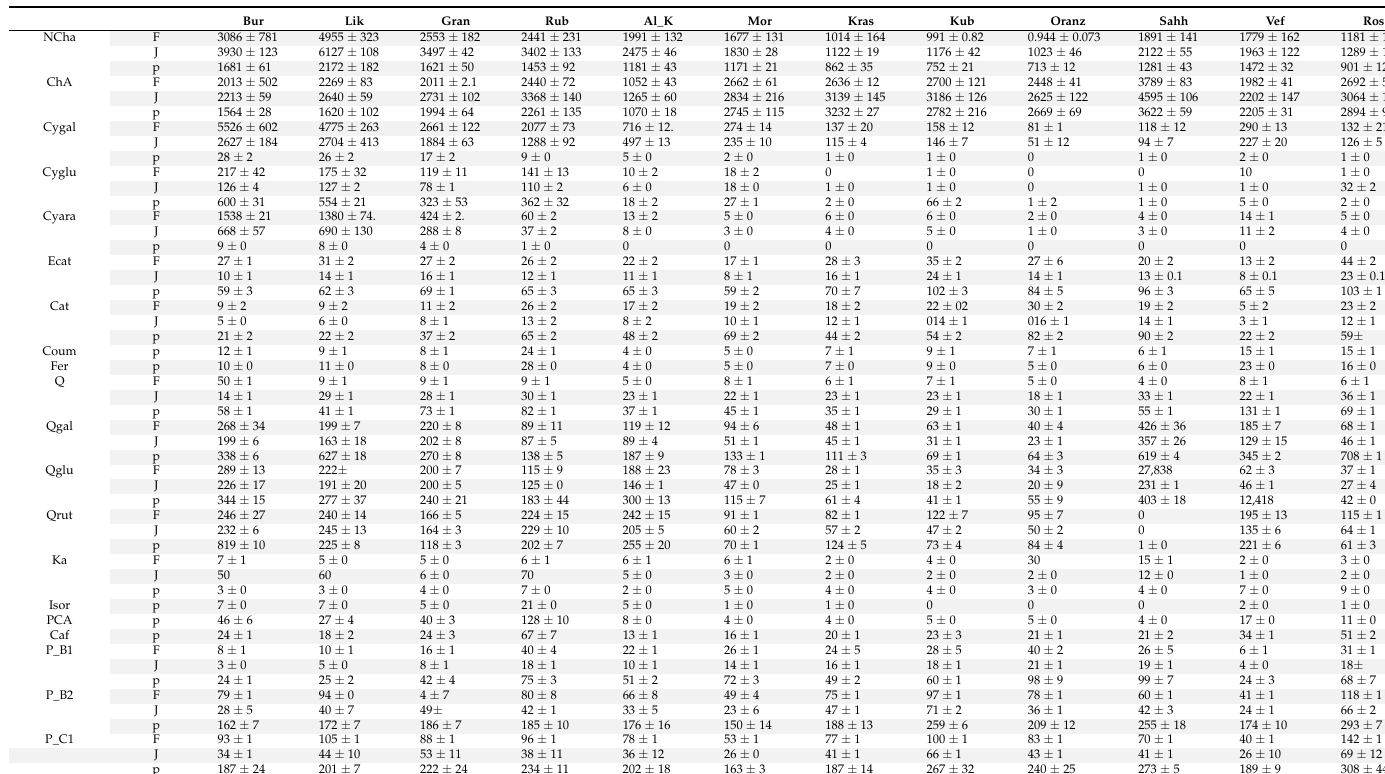
Table 3. The distribution of individual phenolic compounds ( µ g/g dw) in fruit, juice, and pomace extracts of 17 sweet rowanberry